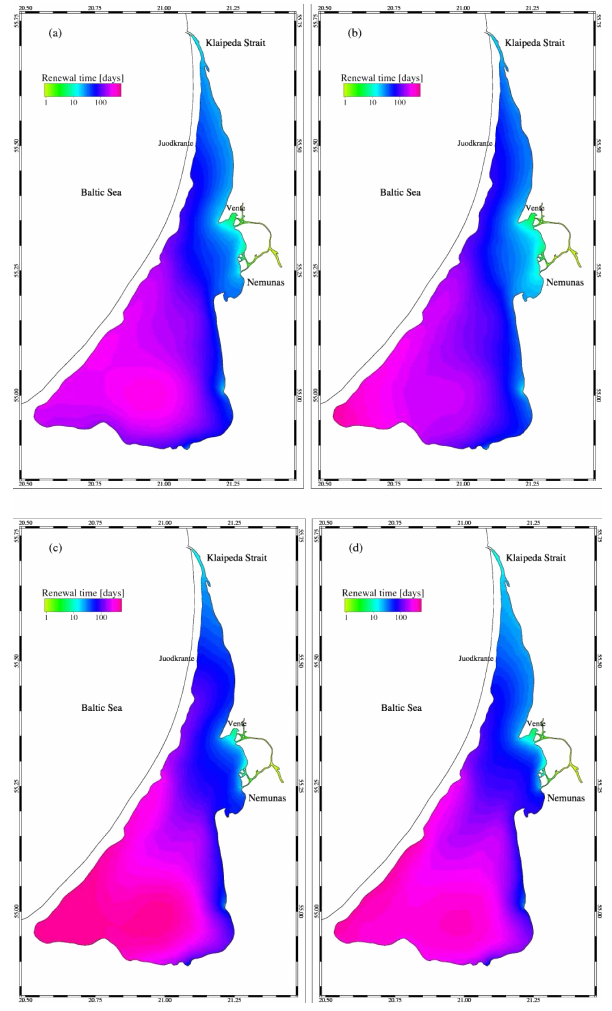
Figure 7. Seasonal renewal time maps averaged over the years 2004–2014. The renewal time is only computed inside the Curonian Lagoon and not in the Baltic Sea. Maps show winter (a) , spring (b) , summer (c) , and autumn (d) . Please note the logarithmic color scale.